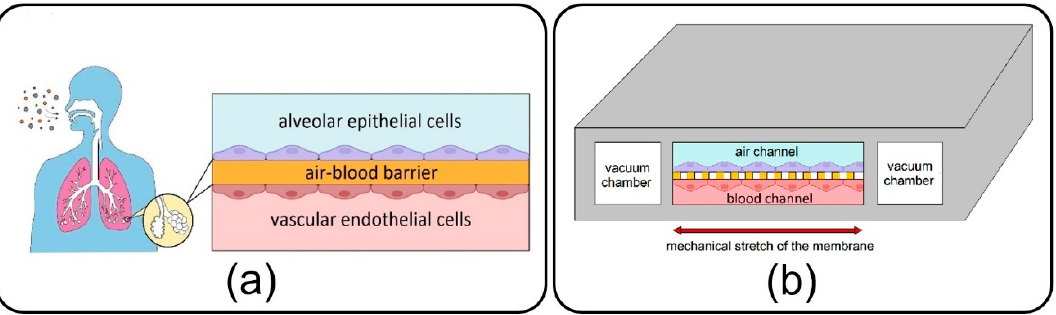
Figure 1. ( a ) Air–blood barrier (ABB) in the alveolar space of human lungs; ( b ) Microfluidic lung- on-a-chip device comprises air/blood channels separated by a thin, porous membrane and two side vacuum channels.